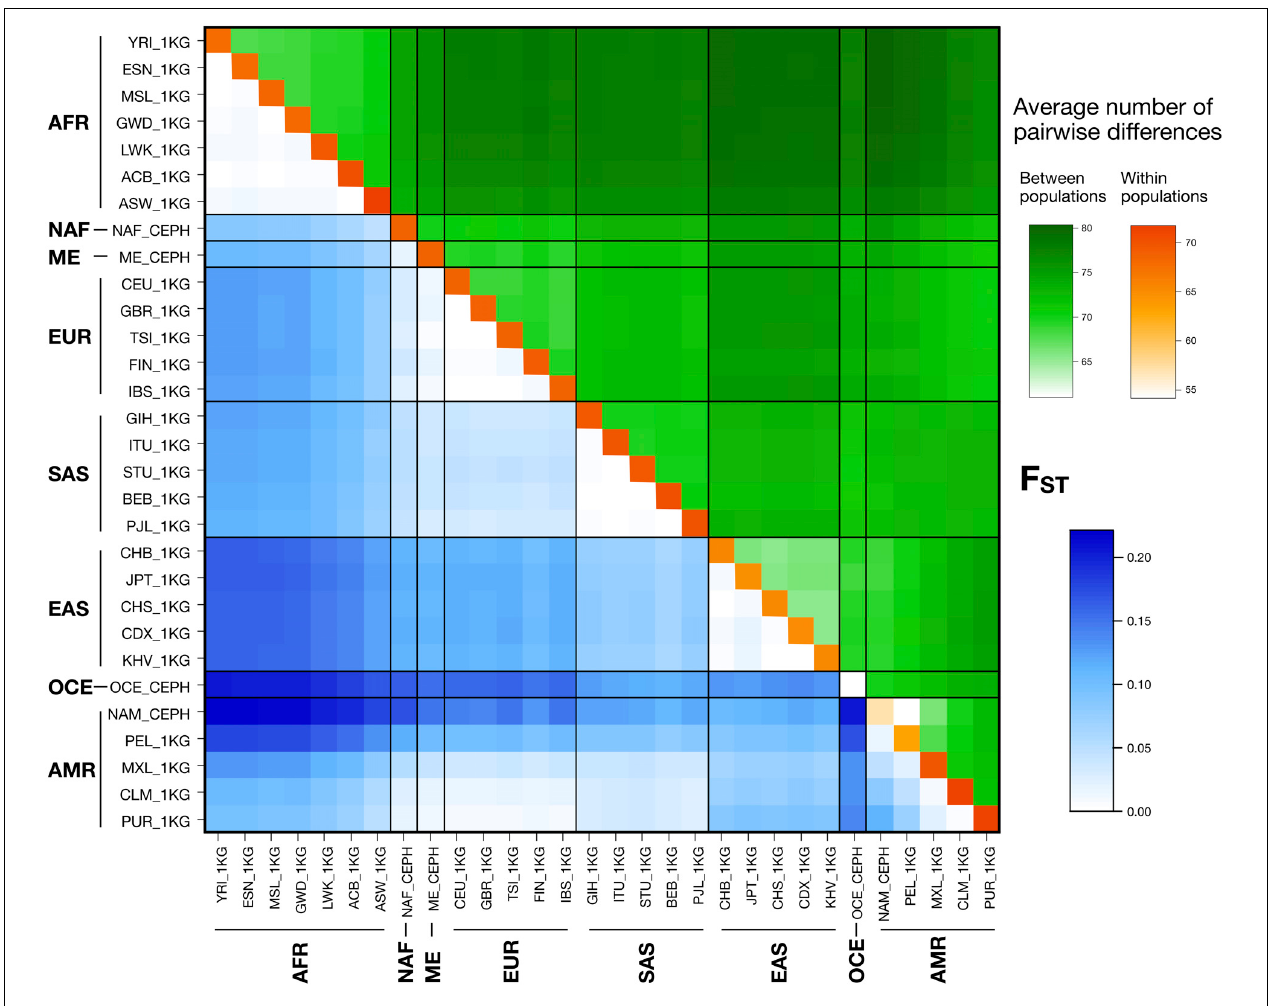
FIGURE 1 | Pairwise F ST (blue) and number of pairwise genotype differences between (green) and within (orange) populations for the autosomal MHs. Populations are named and grouped into eight major populations according to Supplementary Table S5 .